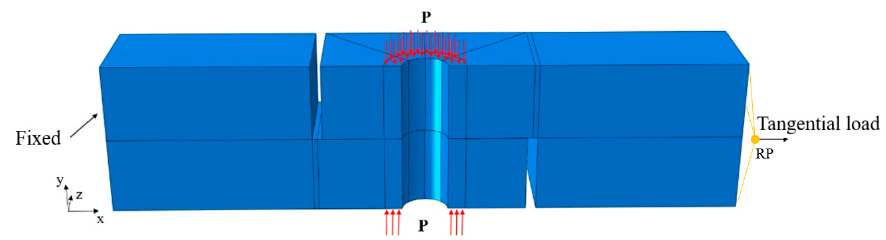
Figure 13. The lapped plate under mixed-mode loading.